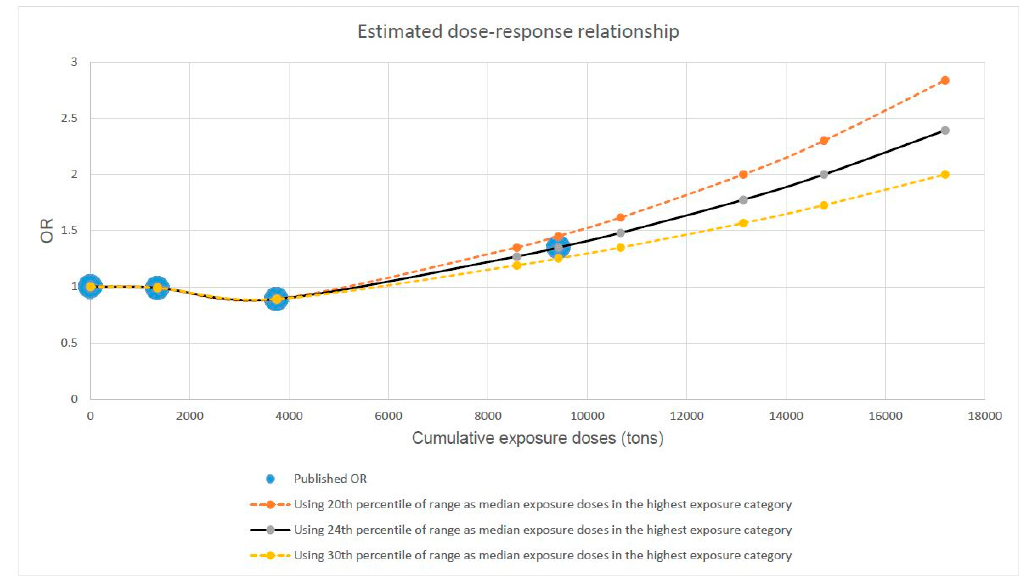
Figure 3. Extrapolated course of the dose–response relationship between heavy lifting and the risk of hip osteoarthritis based on findings published by Rubak et al. 2014 [18].